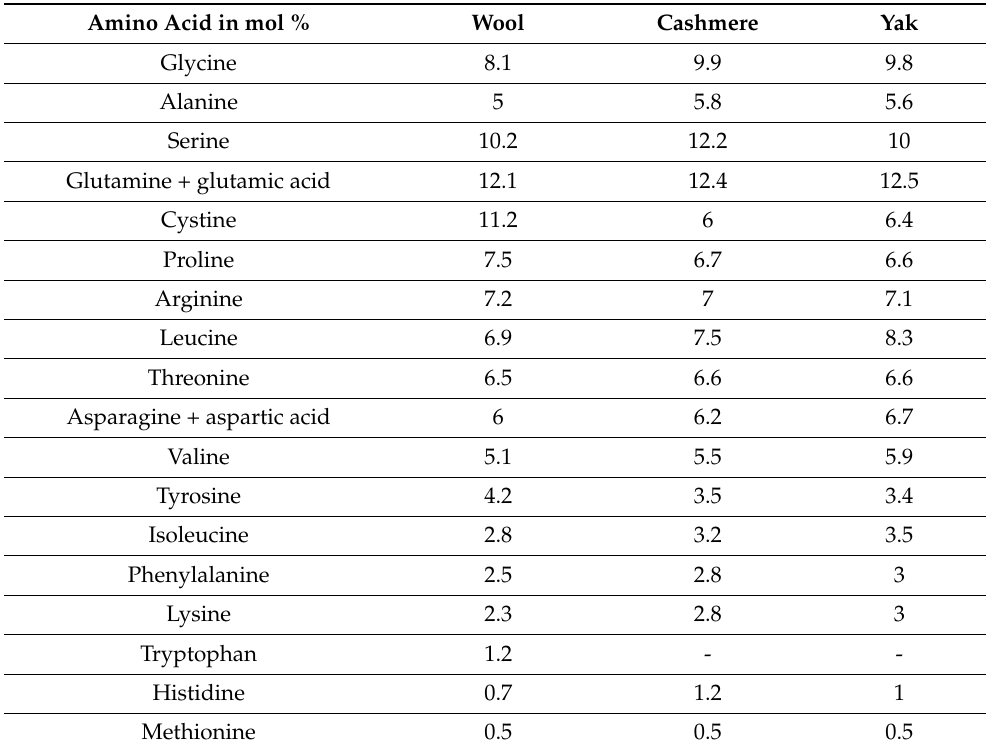
Table 6. Amino acid composition of wool, cashmere, and yak fibers [81,87]. Amino Acid in mol % Wool